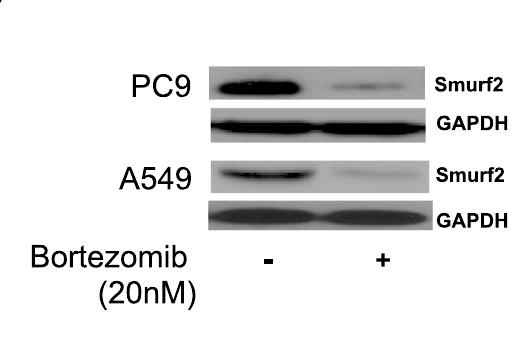
for double-strand DNA breaks. Bortezomib alone did not cause DNA damage (Fig. 3A). Interestingly, the num- bers of γ-H2AX-positive cells were significantly higher in the groups treated with bortezomib plus cisplatin